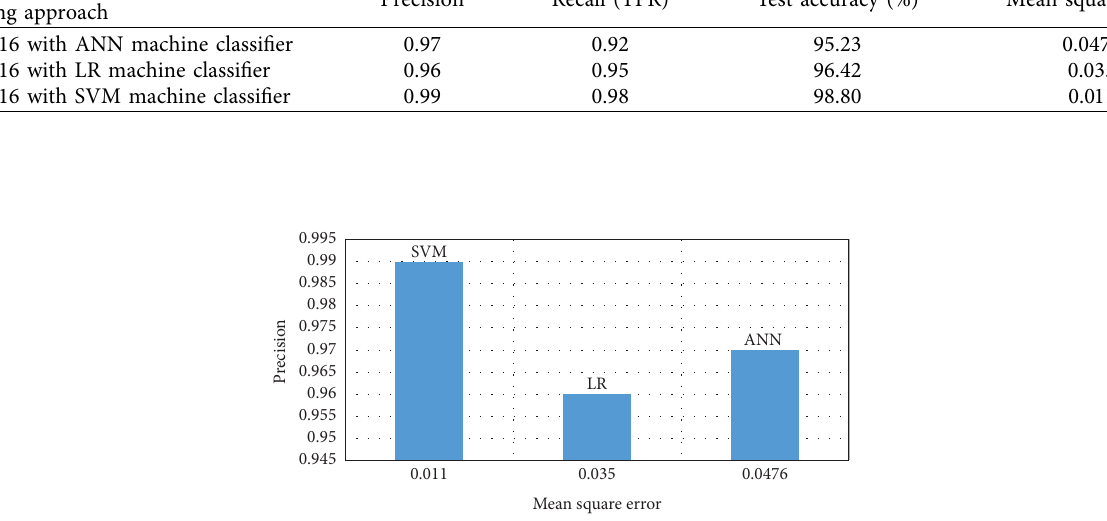
Figure 17: Depicting the precision of test images of the new proposed hybrid learning approach by SVM, LR, and ANN machine classifers with mean square